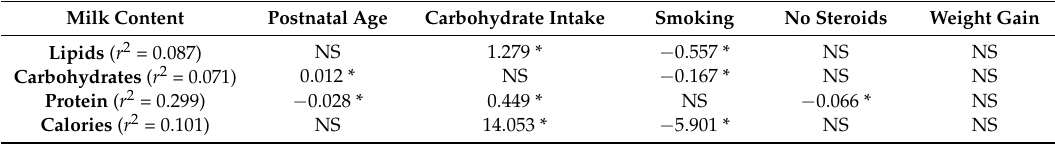
Table 4. Multivariate analysis of factors associated with mothers’ milk